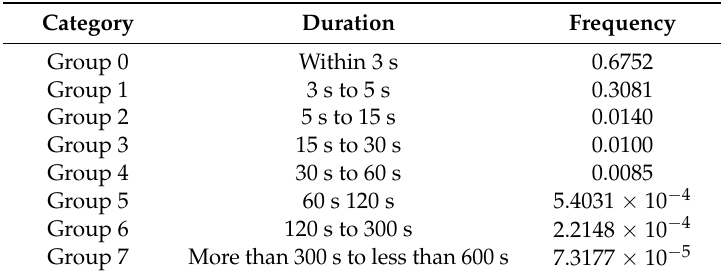
Table 4. Update rate Table 4 . Update rate categorizations.